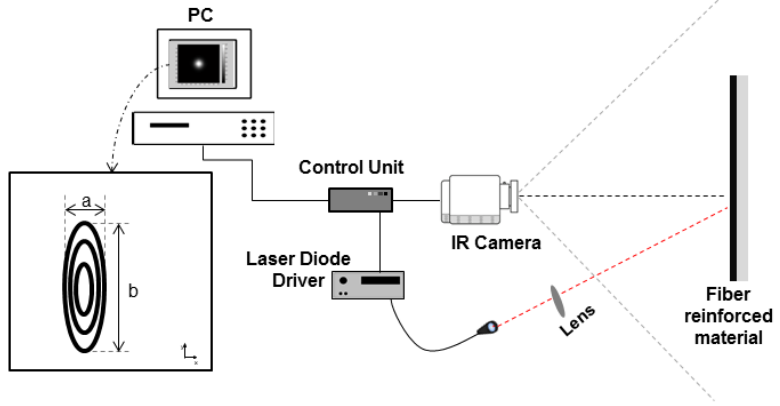
Figure 1. Pulsed Thermal Ellipsometry (PTE) set-up. Adapted from